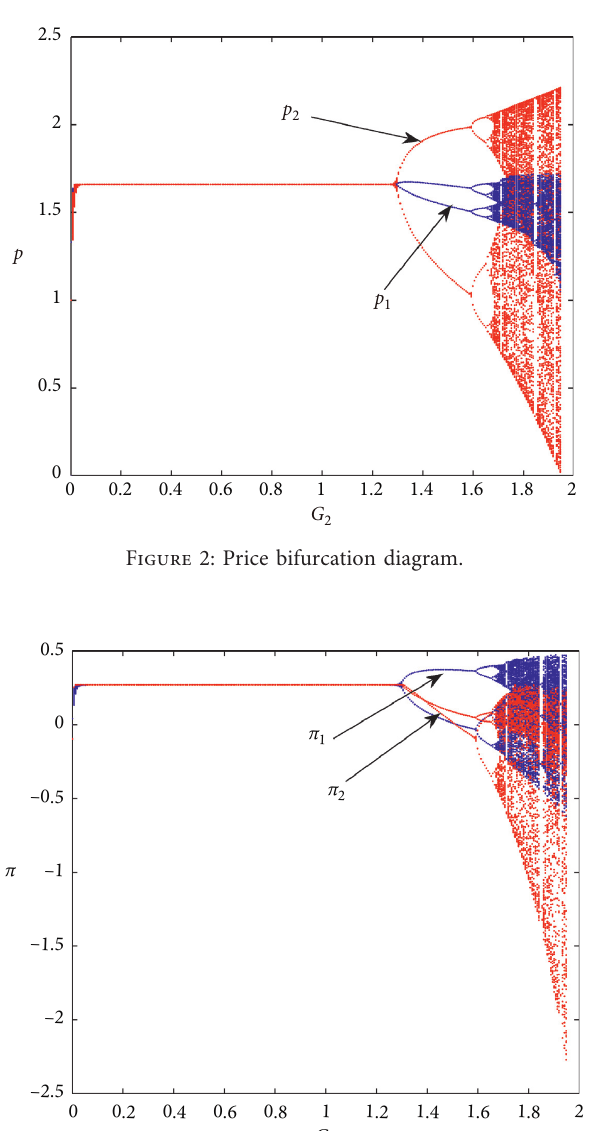
Figure 3: Profit bifurcation diagram.